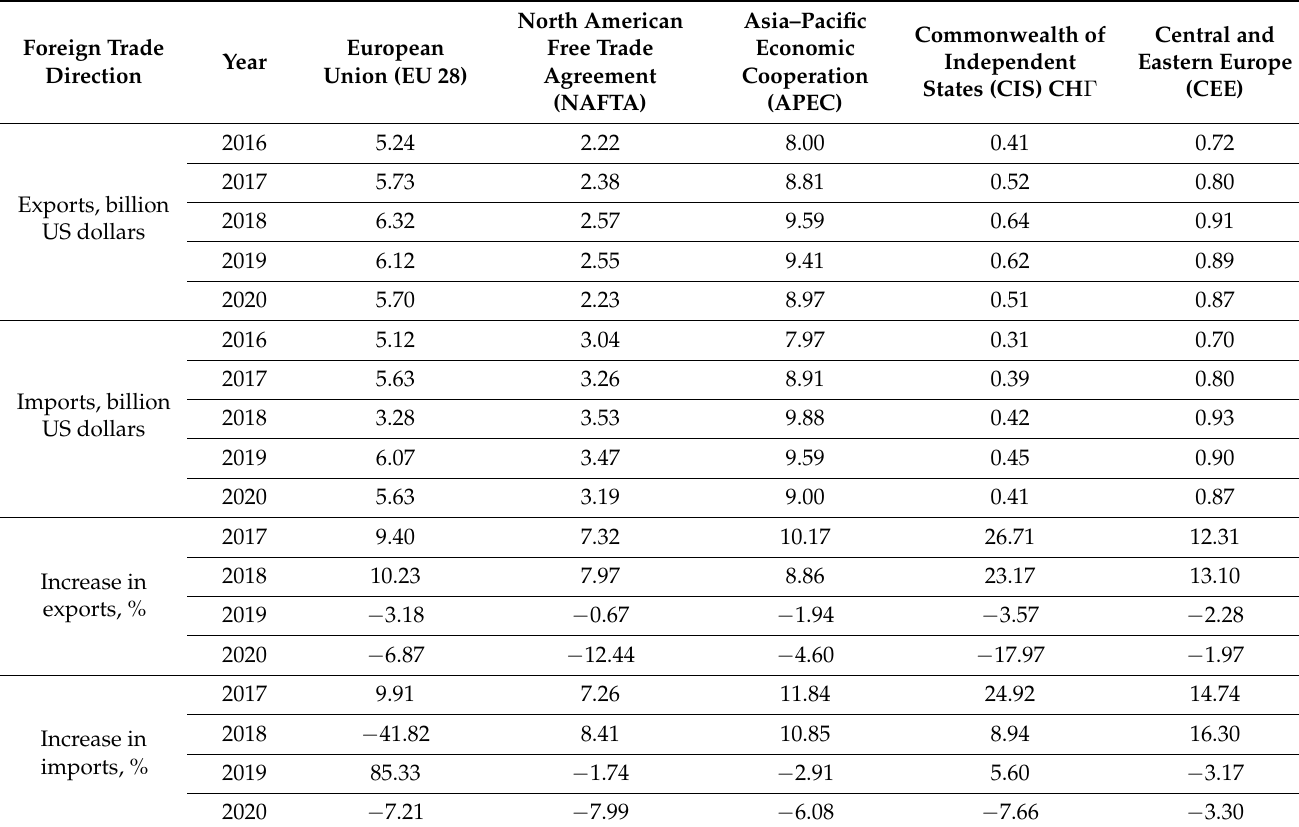
Table 5. The structure and dynamic pattern of international trade in other economic unions